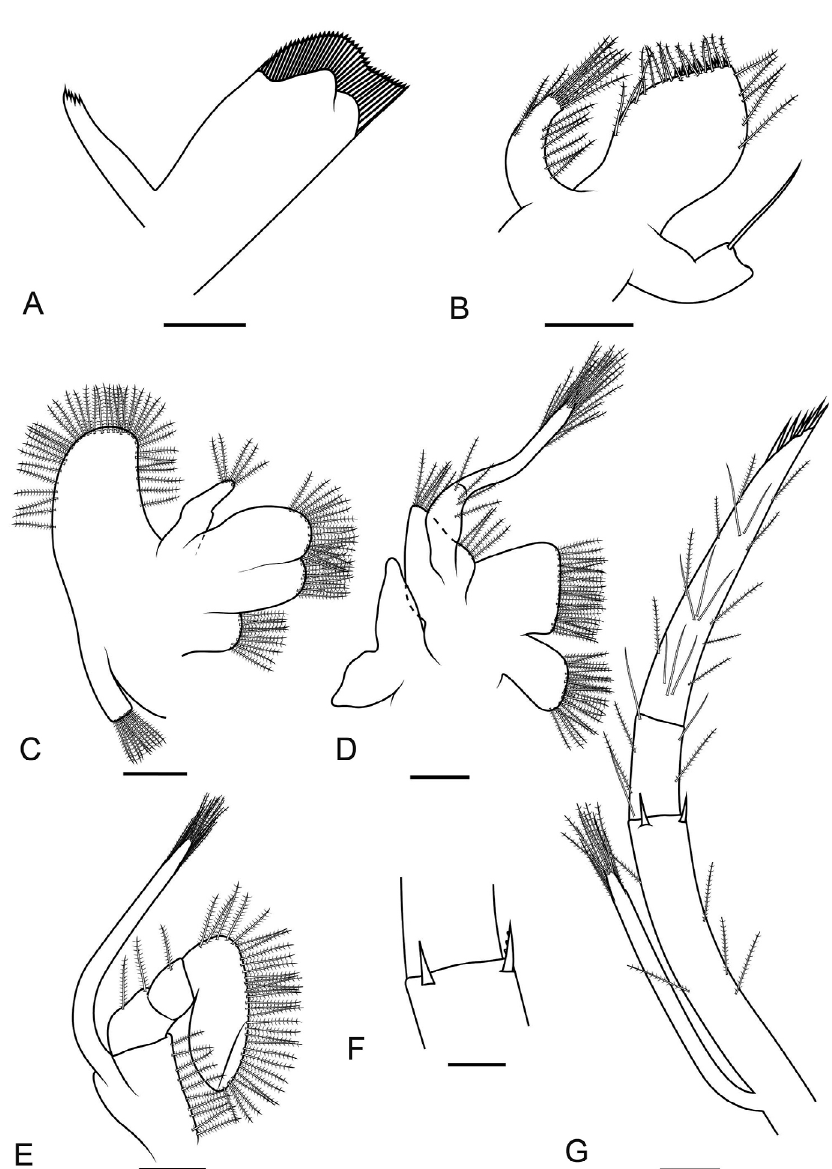
Figure 2. Thor paulae sp. nov. Panama, Bocas del Toro. Paratypes, females (A, B, D, E - UF 44393; C, F, G - UF 44518). A , Right mandible, ventral view; B , right maxillule, ventral view; C , left maxilla, ventral view; D , left first maxilliped, ventral view; E , left second maxilliped, ventral view; F , detail of the third maxilliped with papillose seta, ventral view; G , left third maxilliped, ventral view. Scale bars: A–E, G: 0.25 mm; F: 0.06